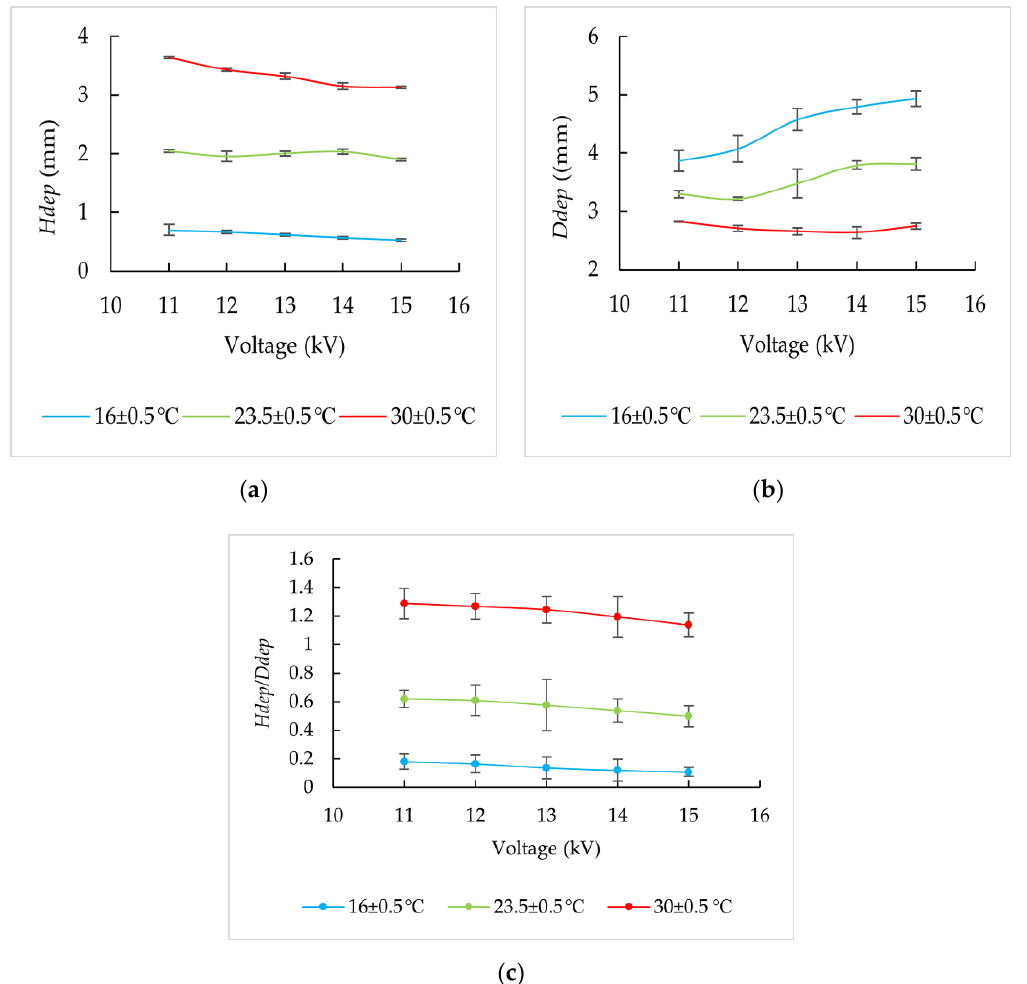
Figure 5. E ff ect of voltage on the formation of fiber accumulation geometry: ( a ) e ff ects of voltage Figure 5. Effect of voltage on the formation of fiber accumulation geometry: ( a ) effects of voltage on on H dep ; ( b ) e ff ects of voltage on D dep ; ( c ) e ff ects of voltage on H dep / D dep . As the voltage H dep ; ( b ) effects of voltage on D dep ; ( c ) effects of voltage on H dep /D dep . As the voltage increases, H dep decreases slightly and D dep increases slightly, except for 30 °C. The calculated ratio, H dep /D dep, decreases slightly.